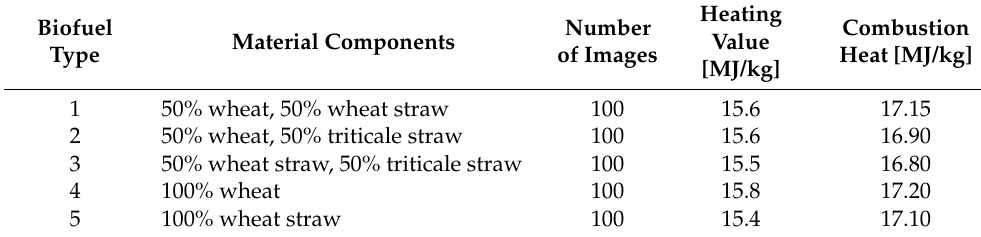
Table 1. Sample data for the tested biofuel